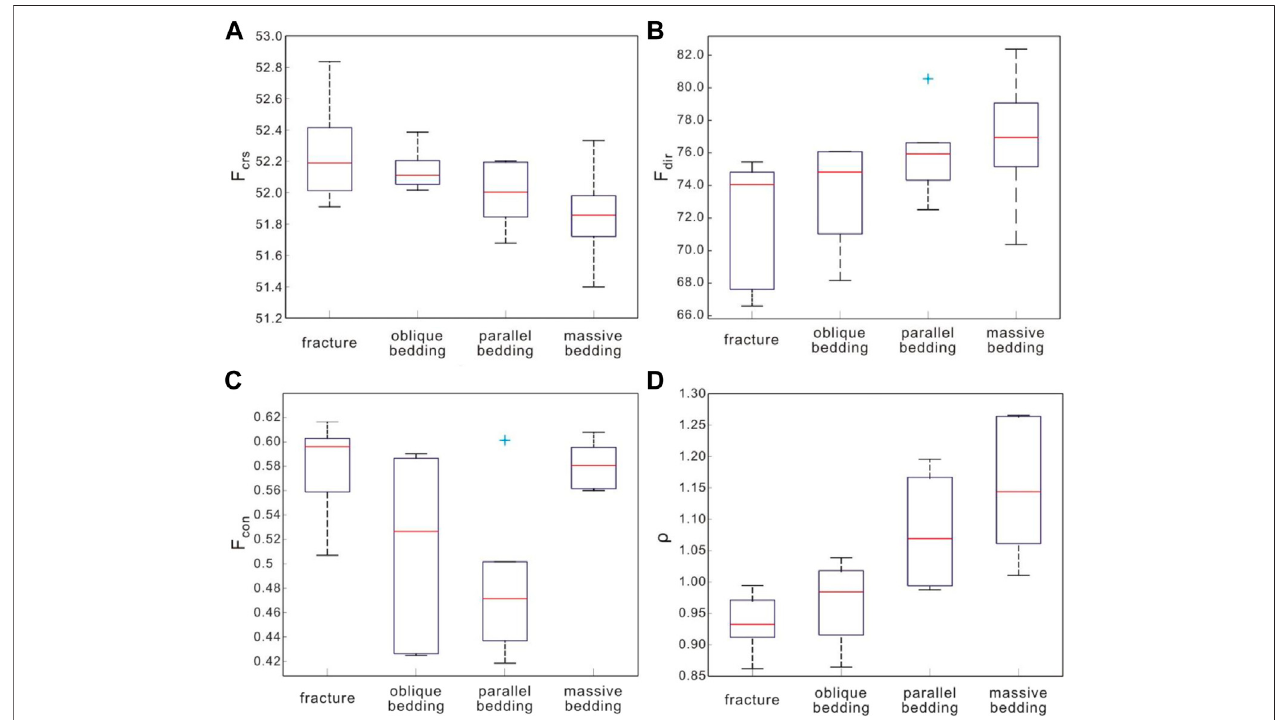
FIGURE 11 | Comparison between TTF analysis results and EMD analysis results. (A) Roughness of image log; (B) Directivity of image log; (C) contrast of image log; (D) Roughness of GR curve.